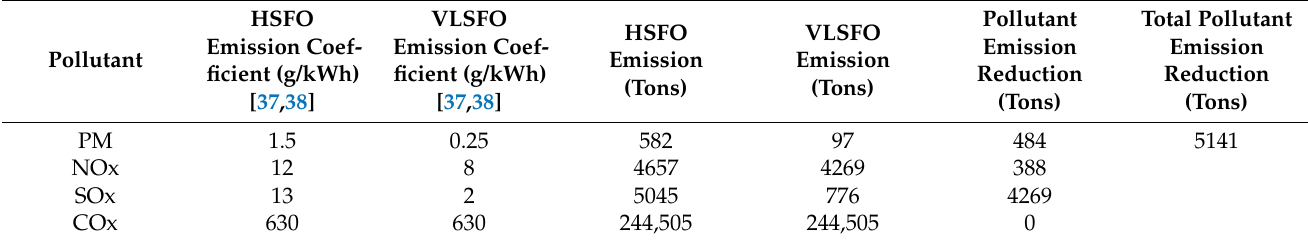
Table 8. Annual pollutant emission reduction of Strategy VLSFO.